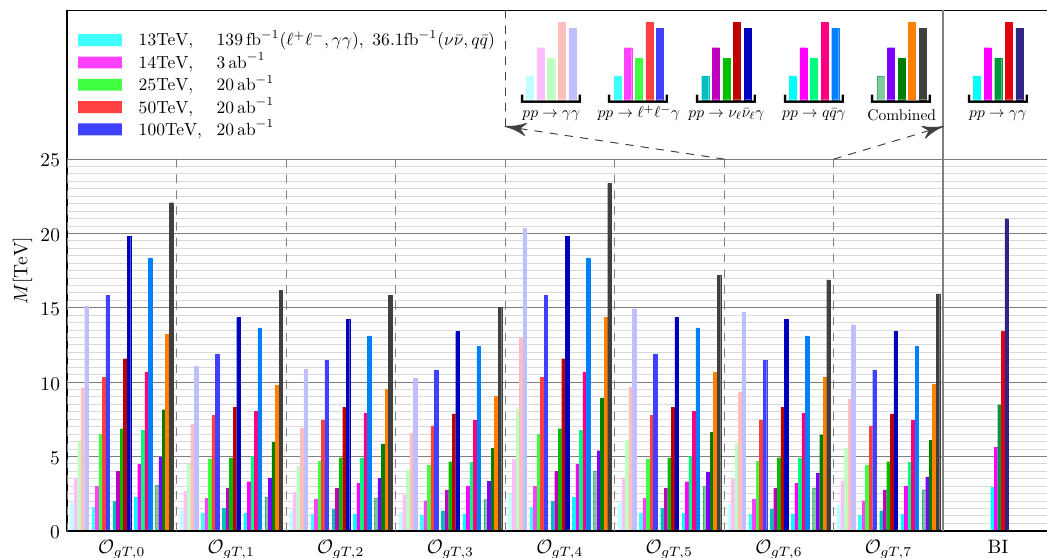
Figure 9 . The 95% C.L. sensitivities of the various channels at the LHC, HL-LHC and proposed future hadron colliders, with cuts given in table